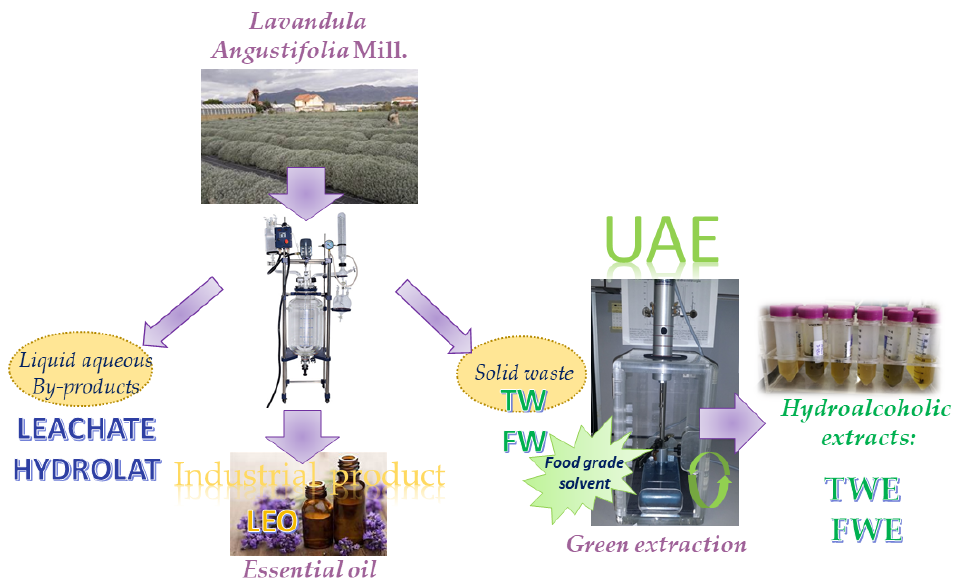
Figure 2. The global scheme of this research.